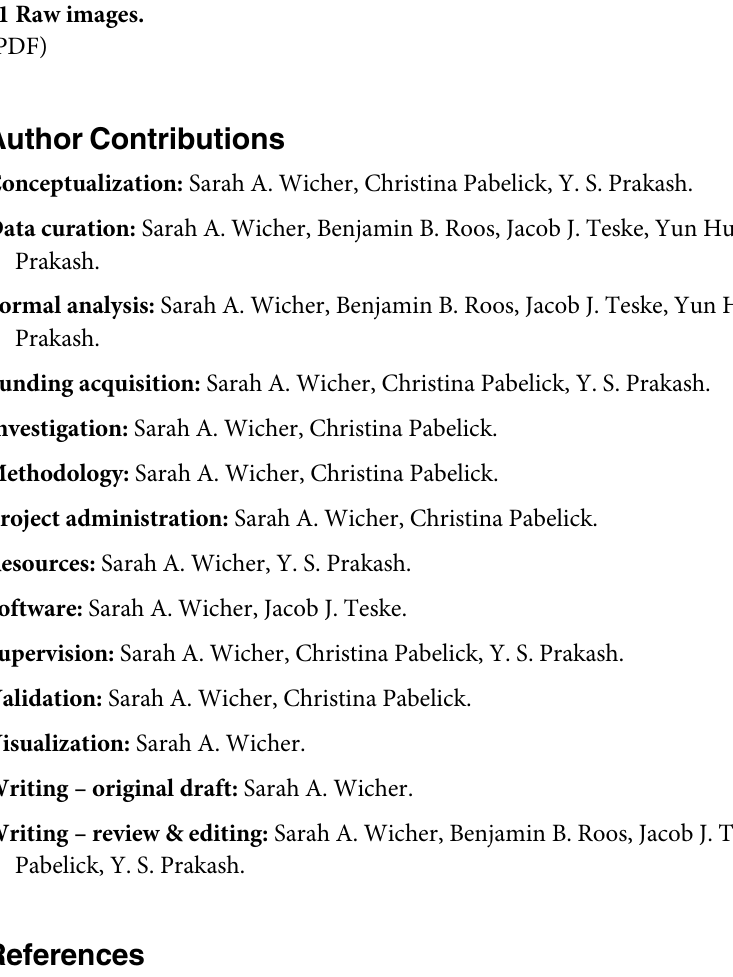
S1 Table. Gene expression for S16, p21, p16, and p53 were analyzed using qRT-PCR. The Ct value range for each age group are listed under the gene